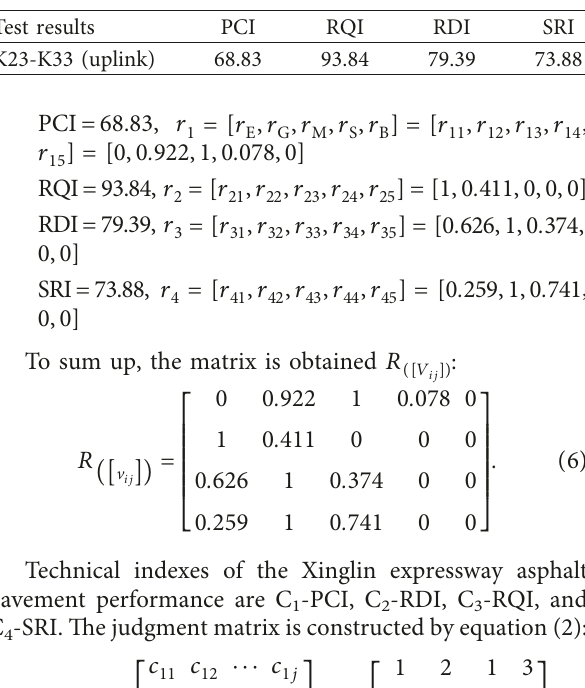
Table 3: Section K23-K33 performance evaluation